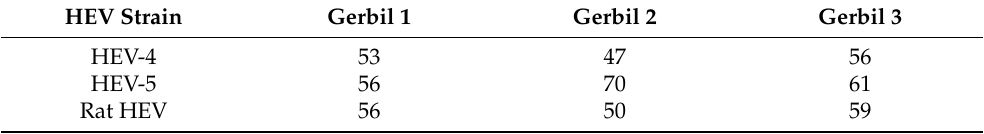
Figure 4. HEV-4, HEV-5 and rat HEV orally transmitted to Mongolia gerbils. Nine Mongolia gerbils were randomly separated into three groups ( n = 3 per group). Individual gerbils are indicated by (cid:52) and (cid:3) ( a , b , d , e , g , h ) or white, gray and black bars ( c , f , i ). Each group was orally inoculated with HEV-4, HEV-5 or rat HEV. The kinetics of the viral RNA in the fecal specimens were determined by RT-qPCR ( a , d , g ). The liver, spleen, bile and serum samples were collected at the end of the experiment (day 26 p.i.). The serum anti-HEV IgG antibodies were detected by using an ELISA with either the VLPs of HEV-1 (to detect HEV-4 and HEV-5) or those of rat HEV (to detect rat HEV) as the antigens. Dotted lines: the cut-off value and the minimum endpoints of the antibody titers were blackened ( • , (cid:78) , (cid:4) ) ( b , e , h ). The viral RNA titers in the liver, spleen, bile and serum ( c , f , i ). The ALT levels measured on day 26 p.i. were 47 to 70 IU/L, and no ALT elevation was observed (Table 3). These results indicated that HEV-4, HEV-5 and rat HEV were transmitted to Mongolia gerbils by an oral-fecal route. Table 3. ALT (IU/L) in the sera collected from orally inoculated Mongolia gerbils on day 26 p.i. HEV Strain Gerbil 1 Gerbil 2 Gerbil 3 HEV-4 53 HEV-5 Rat